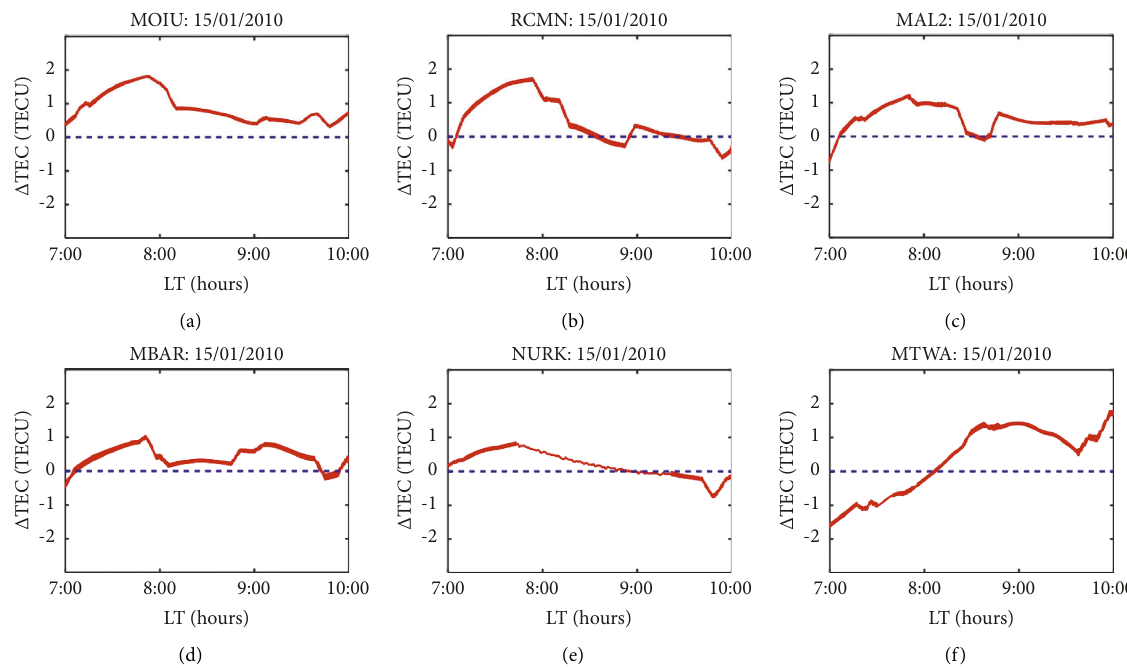
Figure 3: The detrended TEC (red line) and mean level (blue line) variation with local time (LT) over (a) MOIU, (b) RCM, (c) MAL2, (d) MBAR, (e) NURK, and (f) MTWA on 15 th January